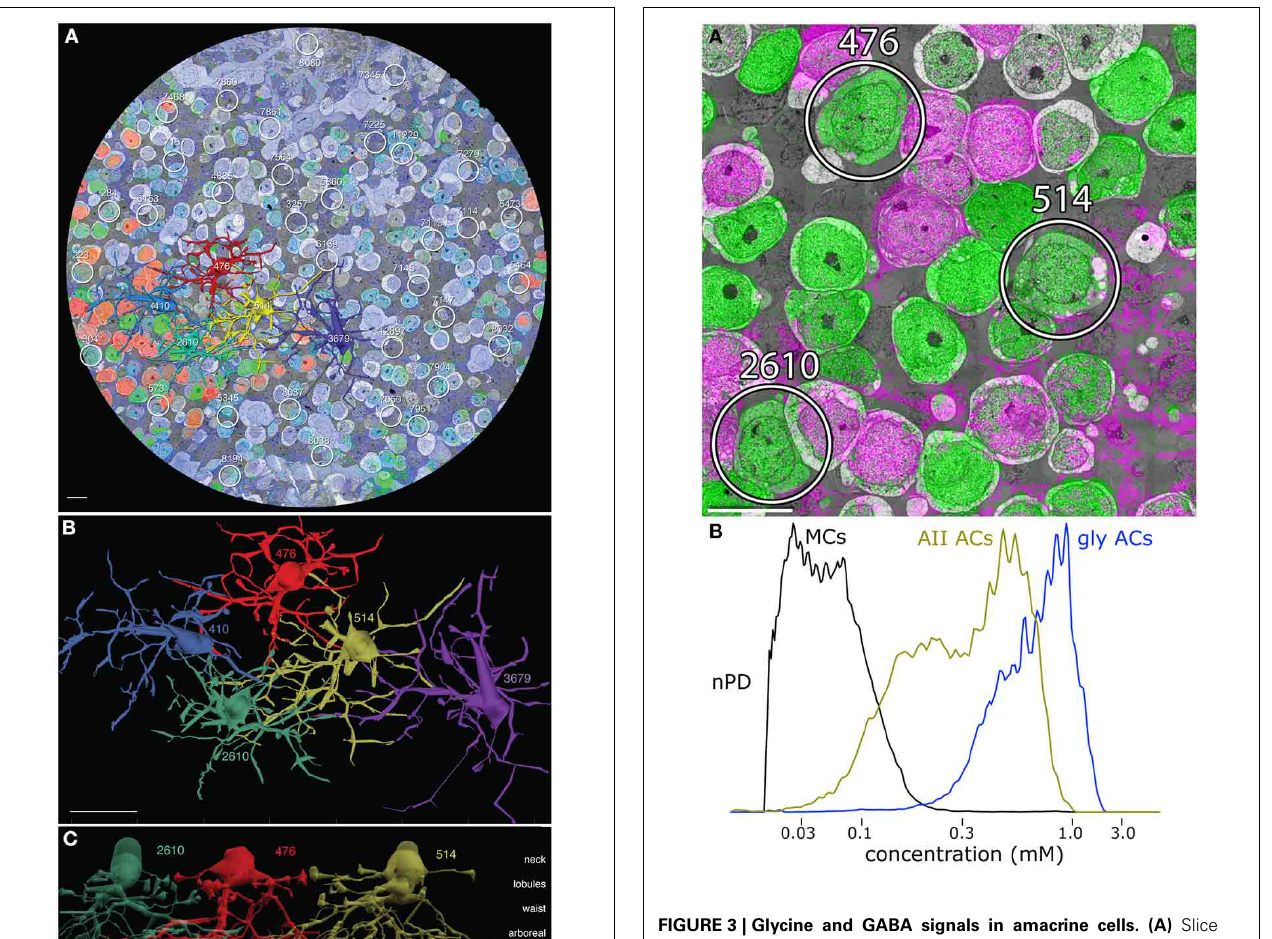
FIGURE 3 | Glycine and GABA signals in amacrine cells. (A) Slice 030, volume RC1. Three of the AII amacrine cells are marked. The gray space in between cells is filled with glial Müller cell processes. The pale gray cells are bipolar cells. Scale 10 μ m. (B) Glycine content histograms distinguish AII cells from other retinal cells. The glycine content of AII cells (AII AC, gold trace) is about 2-fold lower than all other glycinergic amacrine cells combined (gly ACs, blue trace), but over 20-fold higher than signals in glial Müller cell (MCs). The histograms each represent aggregate signals from 25 cells calibrated as described in Marc and Jones (2002) and displayed as normalized probability density (nPD) vs. pixel value scaled as